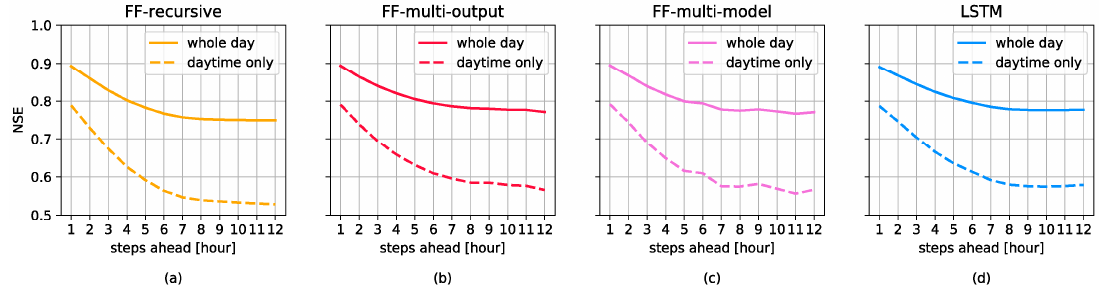
Figure 4. NSE of hourly solar irradiance at Como obtained with recursive FF ( a ), multi-output FF ( b ), multi-model FF ( c ), and LSTM ( d ). Solid line represents the performance in the whole day, dashed line in daytime only. Values refer to the test year 2019.